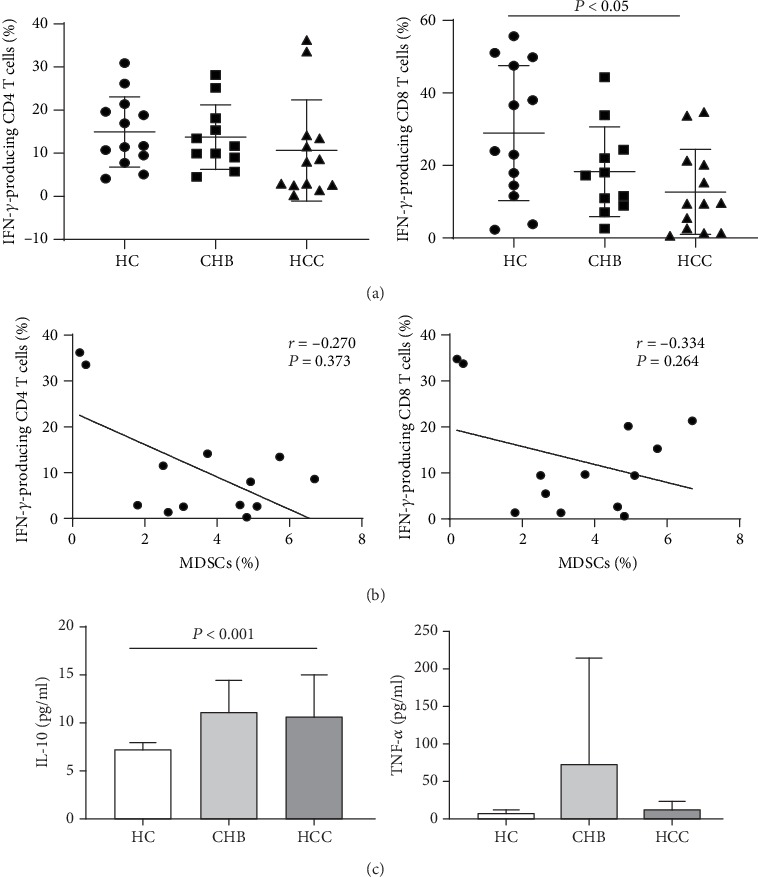
Frequency of IFN-γ-producing CD4 and CD8 T cells and their relationships with MDSCs. (a) The percentages of IFN-γ-producing CD4 and CD8 T cells in HCC patients, CHB patients, and healthy controls. (b) Correlation between MDSCs and IFN-γ-producing CD4 and CD8 T cells. (c) The serum level of IL-10 and TNF-α in HCC patients, CHB patients, and healthy controls.